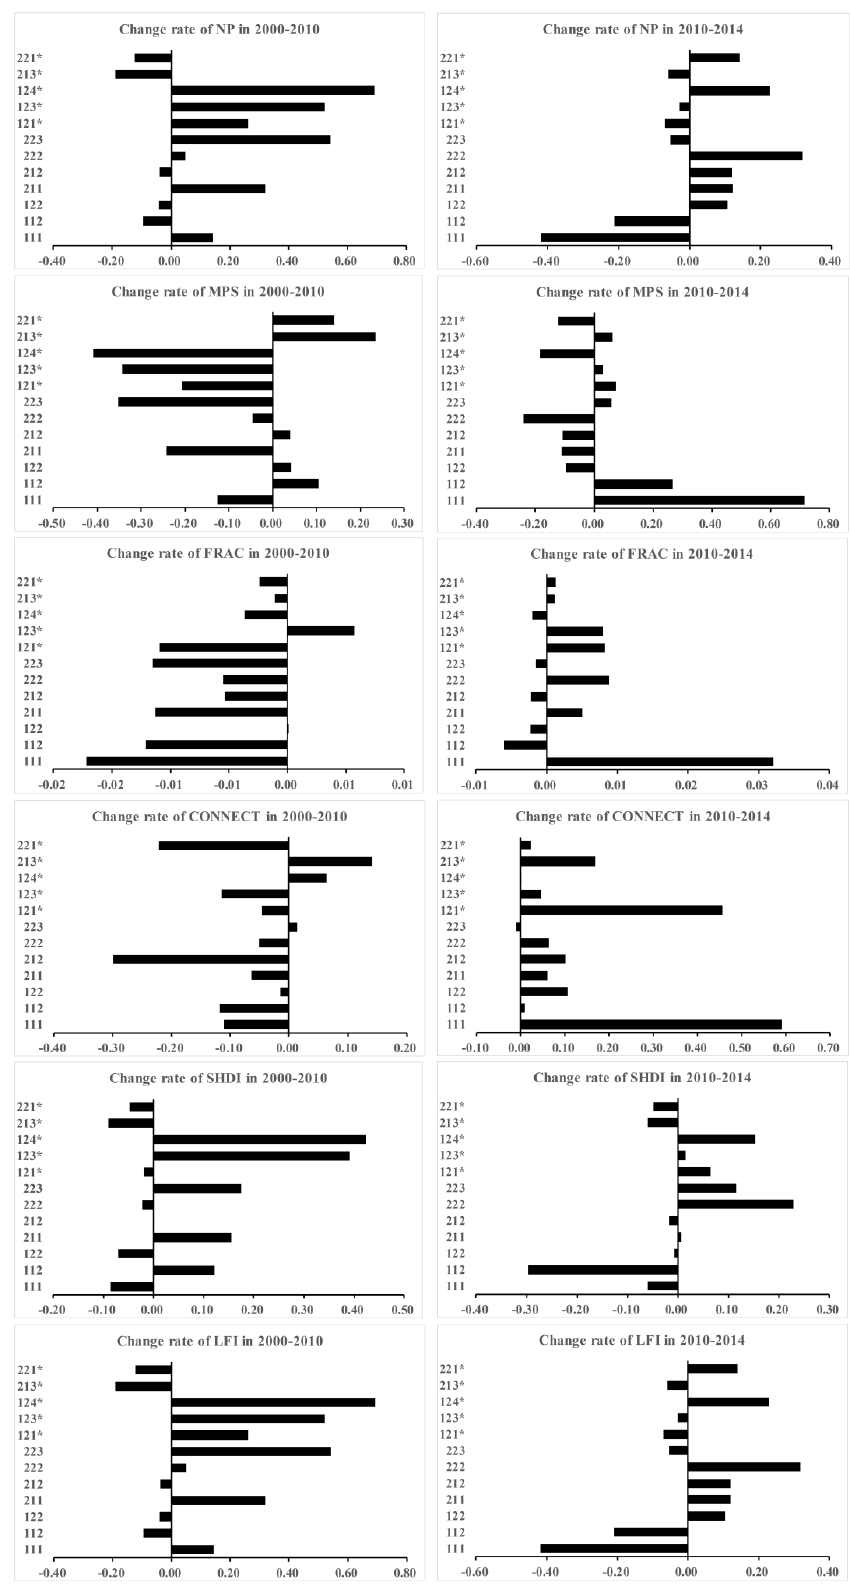
Figure 4. Change rate of landscape indices for each community in 2000–2010 and 2010–2014. * indicates communities that implemented RFFP. Refer to Table 3 for the abbreviations for landscape